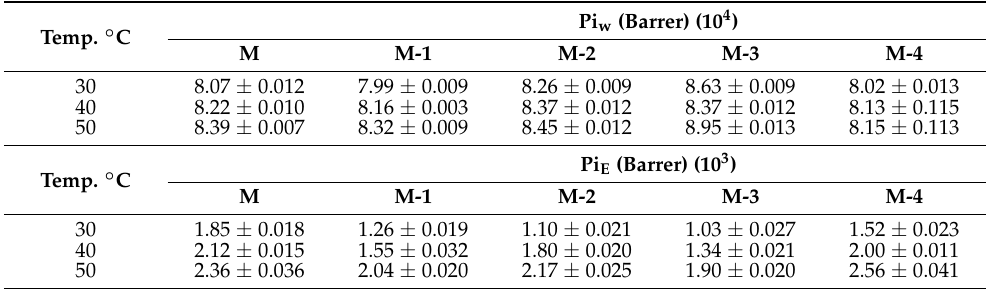
Table 3. The permeability of water and bioethanol of all the membranes at different temperatures. Temp. ◦